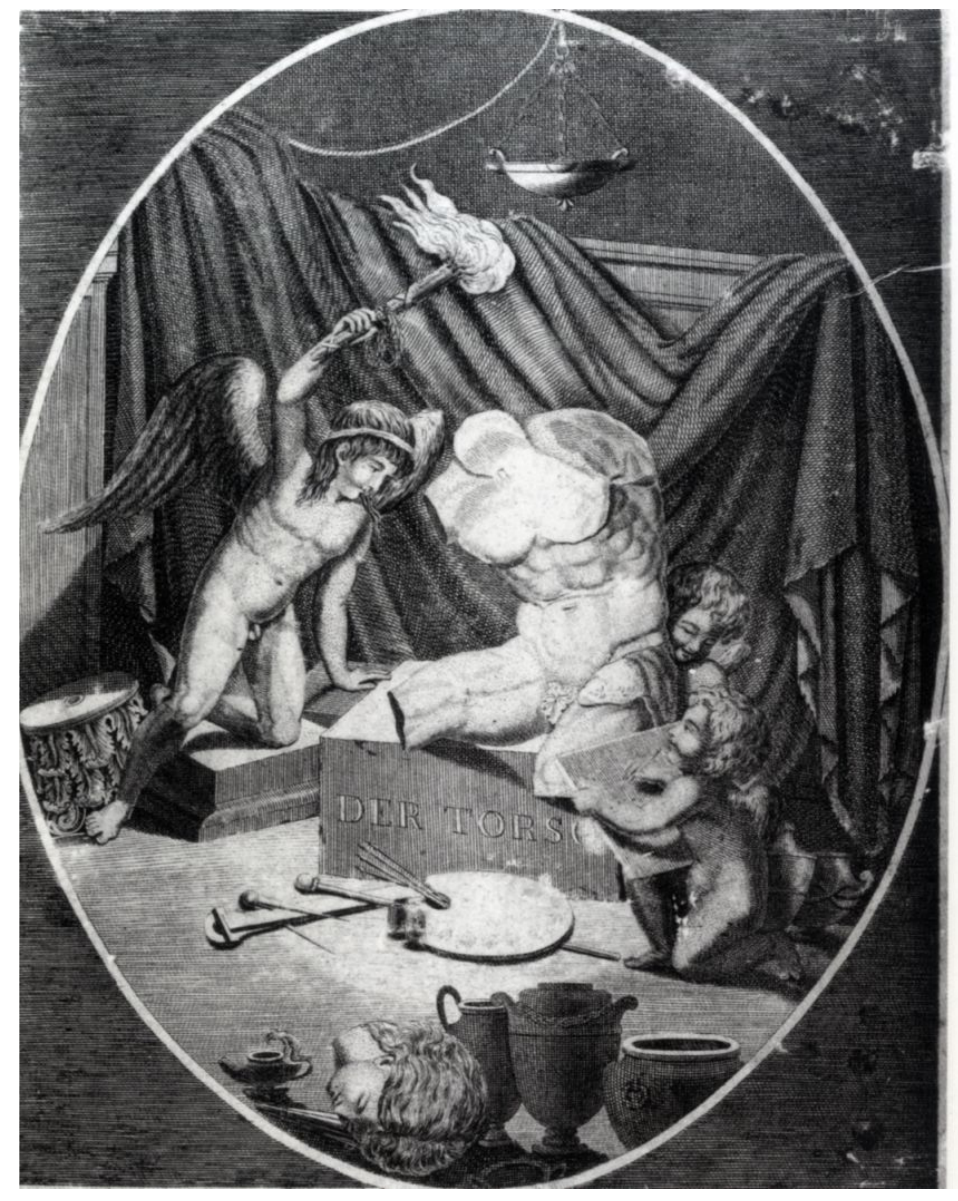
Frontispiece from Der Torso: Eine Zeitschrift der alten und neuen Kunst gewidmet , 1796. From